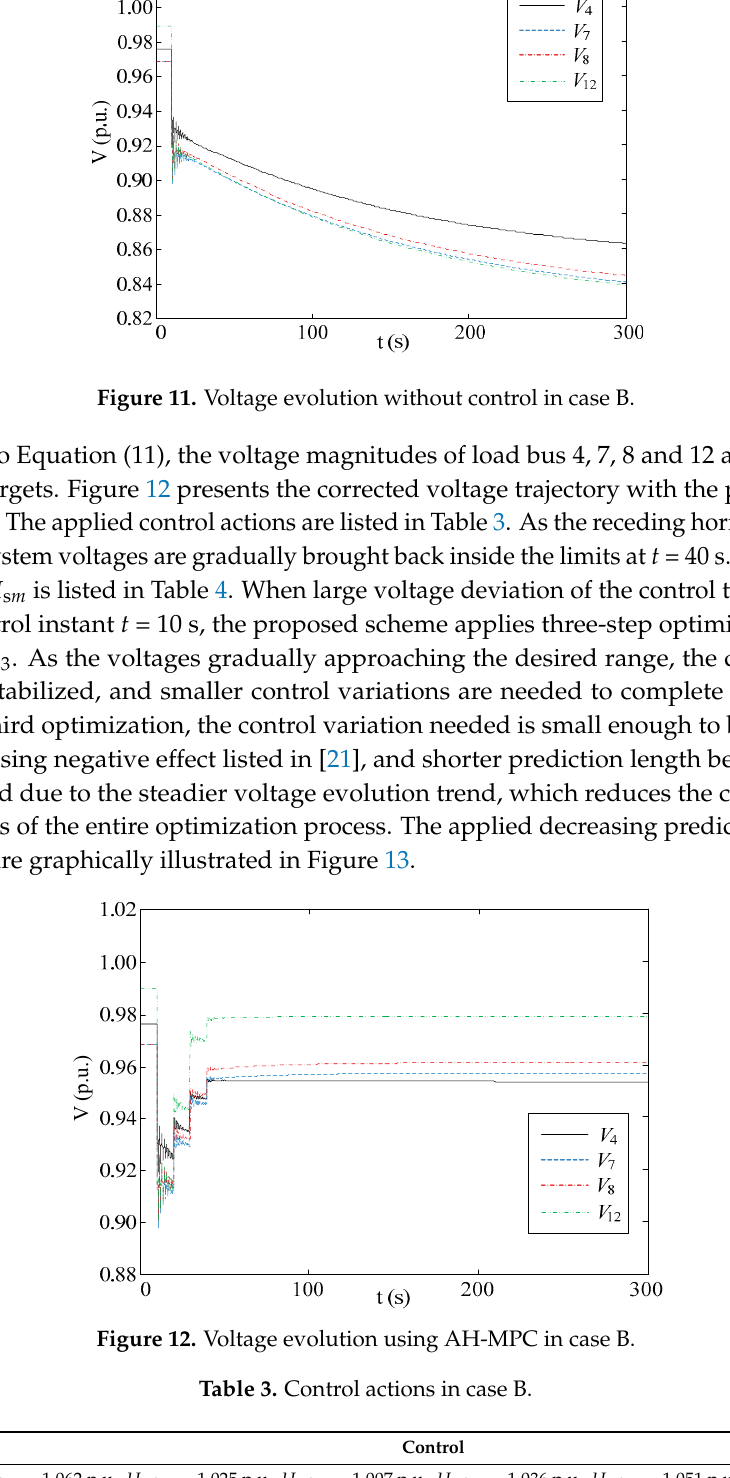
Figure 12. Voltage evolution using AH-MPC in case B.